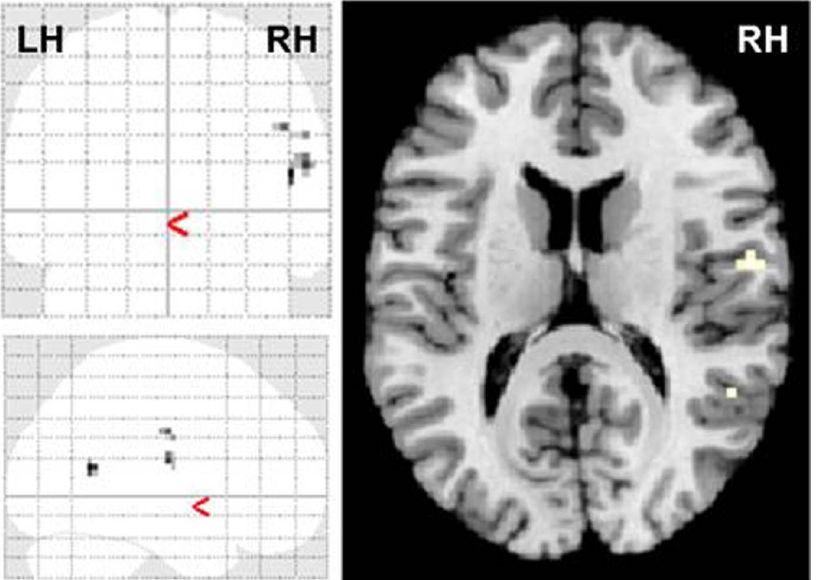
Figure 1. Group comparison healthy controls . schizophrenia for ironic . literal target sentences. p , 0.001, ext. 5 voxels. Differences are present in the right hemisphere middle temporal gyrus, rolandic operculum and postcentral gyrus. The opposite contrast (patients . controls) showed no activated clusters.